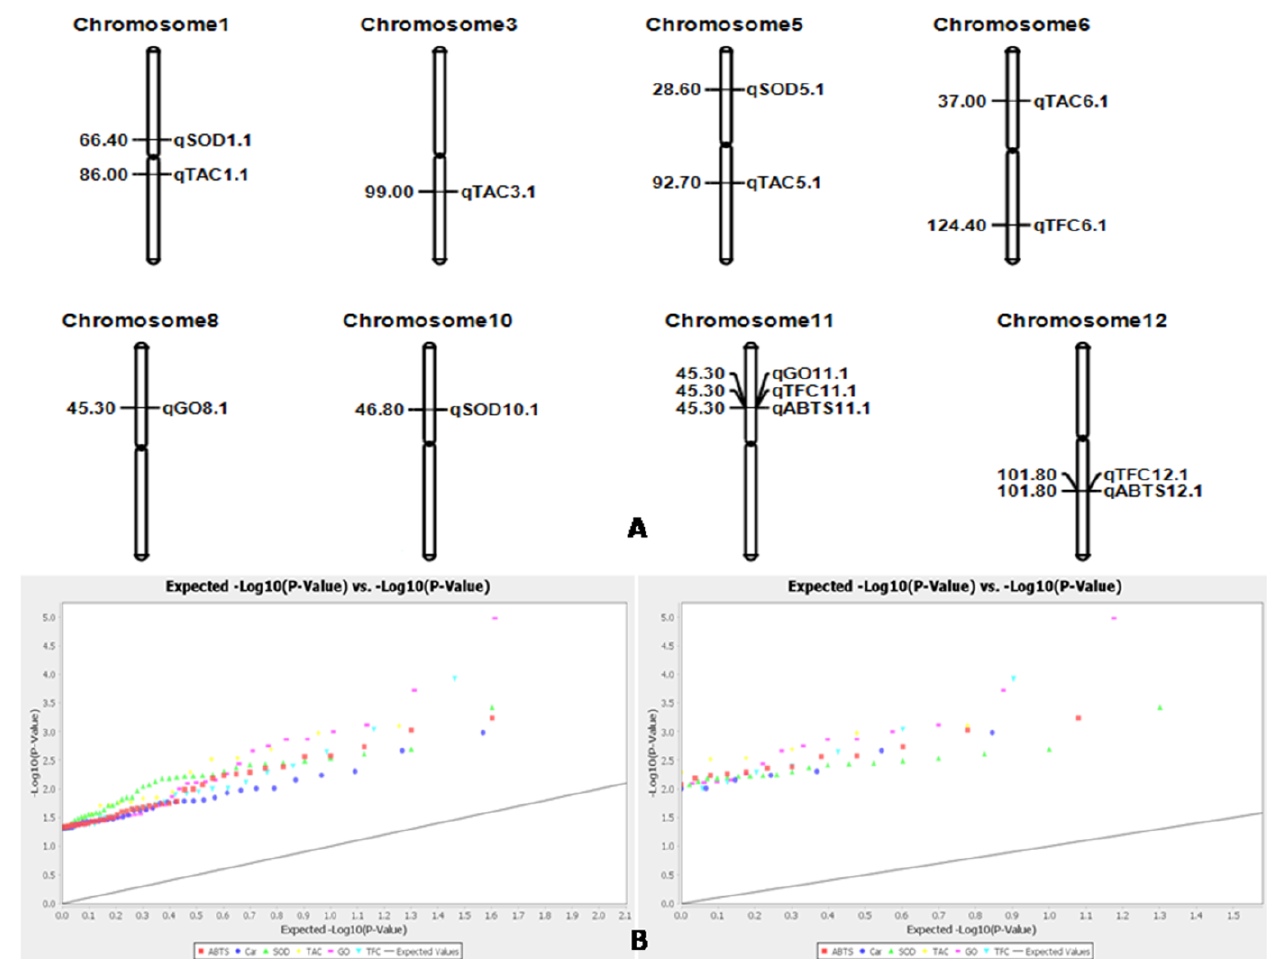
Figure 9. ( A ) Positions of the QTLs on the chromosomes for antioxidant content detected by association mapping in rice. ( B ) Distribution of marker – trait association and quantile – quantile (Q-Q) plot generated from Generalized Linear Model analysis for six antioxidant traits at ( A ) p <0.05 and ( B ) at p <0.01.